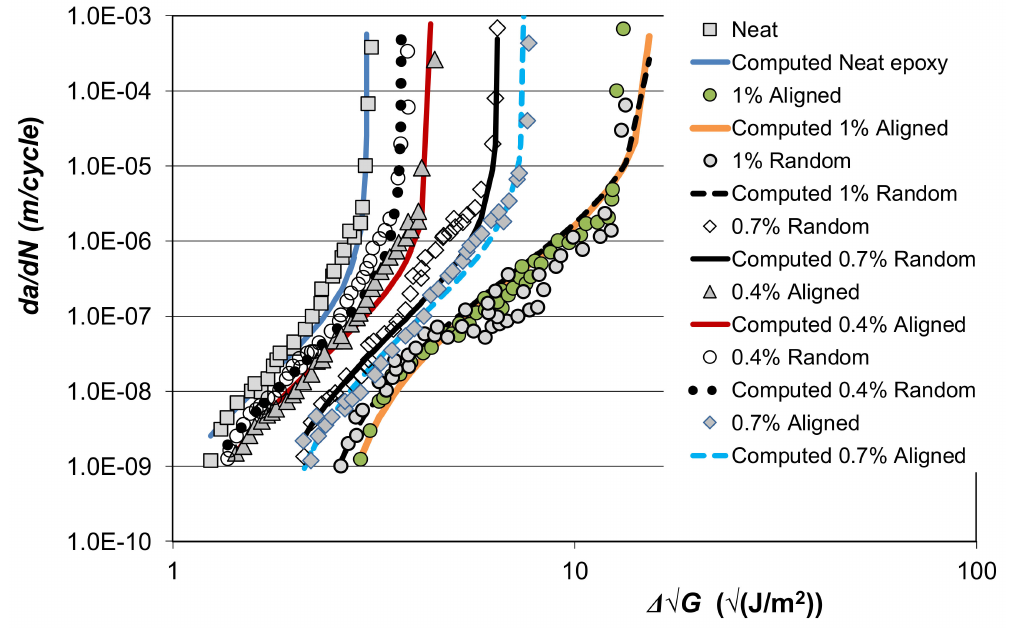
√ G curves in the various √ G curves given in